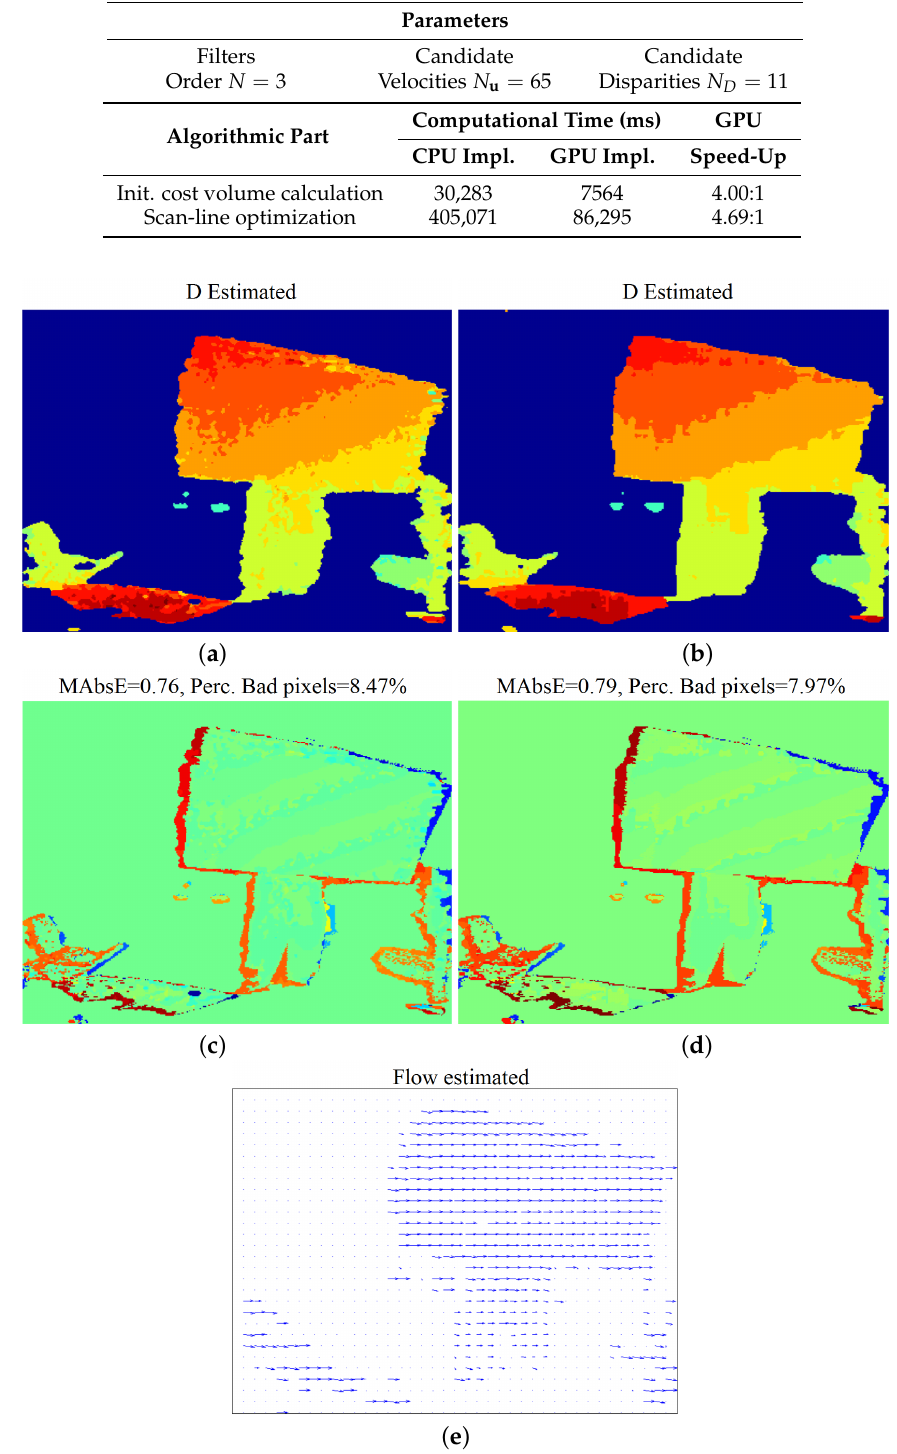
Figure 11. “Dimitris-Chessboard” sequence: experimental results: estimated disparity map ( a ) before and ( b ) after the application of SO; ( c , d ) the corresponding estimation error results; ( e ) estimated flow field after the application of